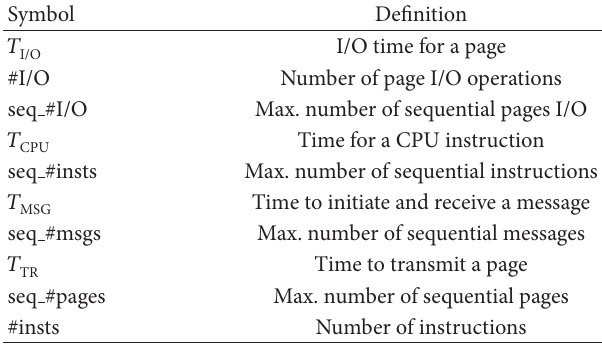
Table 3: Parameters used in the cost model.